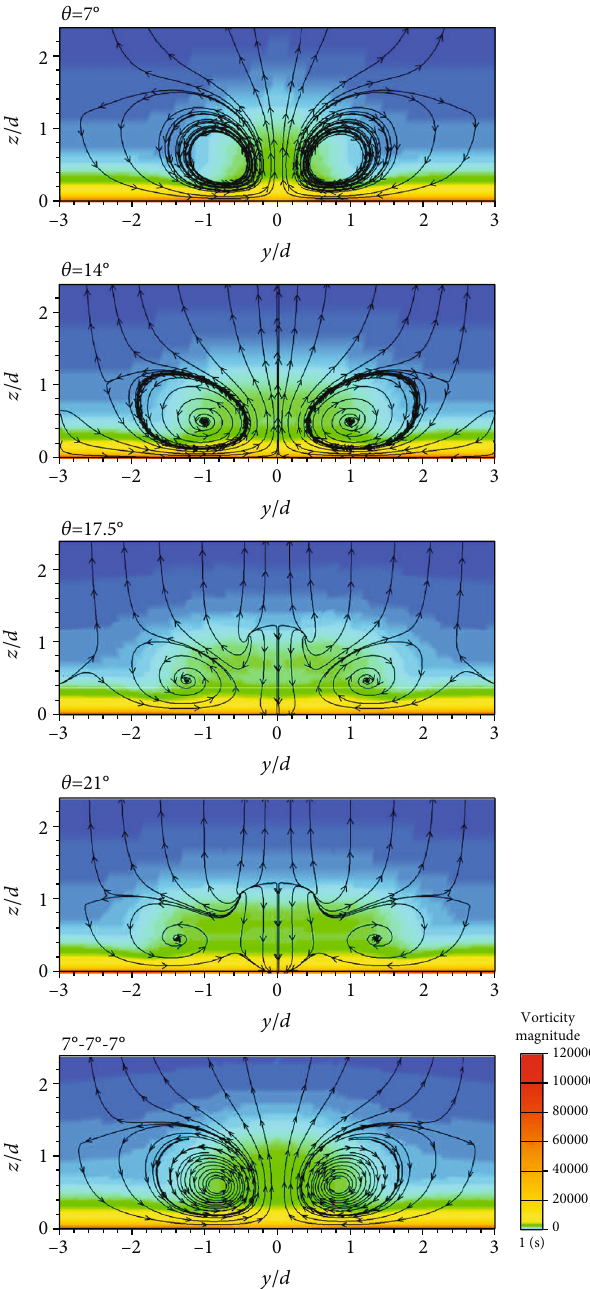
Figure 18: CFD vorticity magnitude contours for M = 1 at x / d = 5 . Figure 19: CFD vorticity magnitude contours for M = 2 at x / d = 5